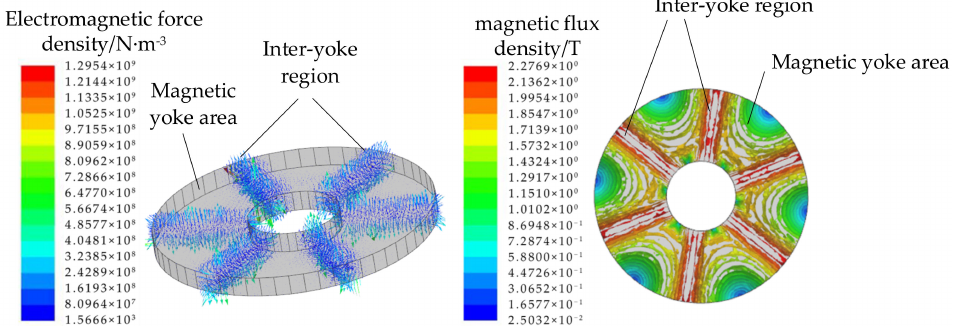
Figure 12. Armature magnetic induction strength and electromagnetic force distribution (t = 2.0